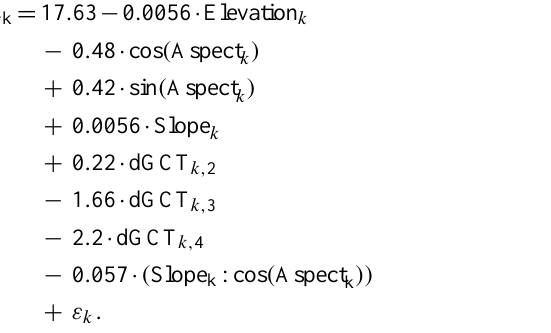
Fig. 6. MAGST of all footprints plotted against elevation. Colors identify the different aspects. Measured MAGST are indicated with a circle, the crosses denote the fitted values from the linear model shown in Eq. (3).